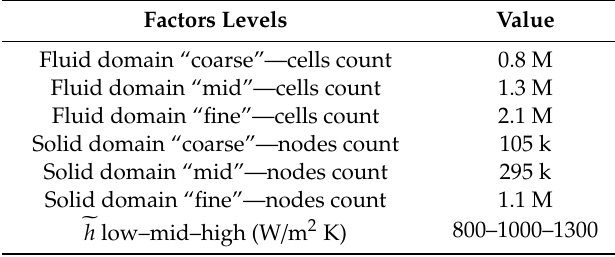
Table 3. Fluid and solid mesh refinements, (cid:101) h levels.